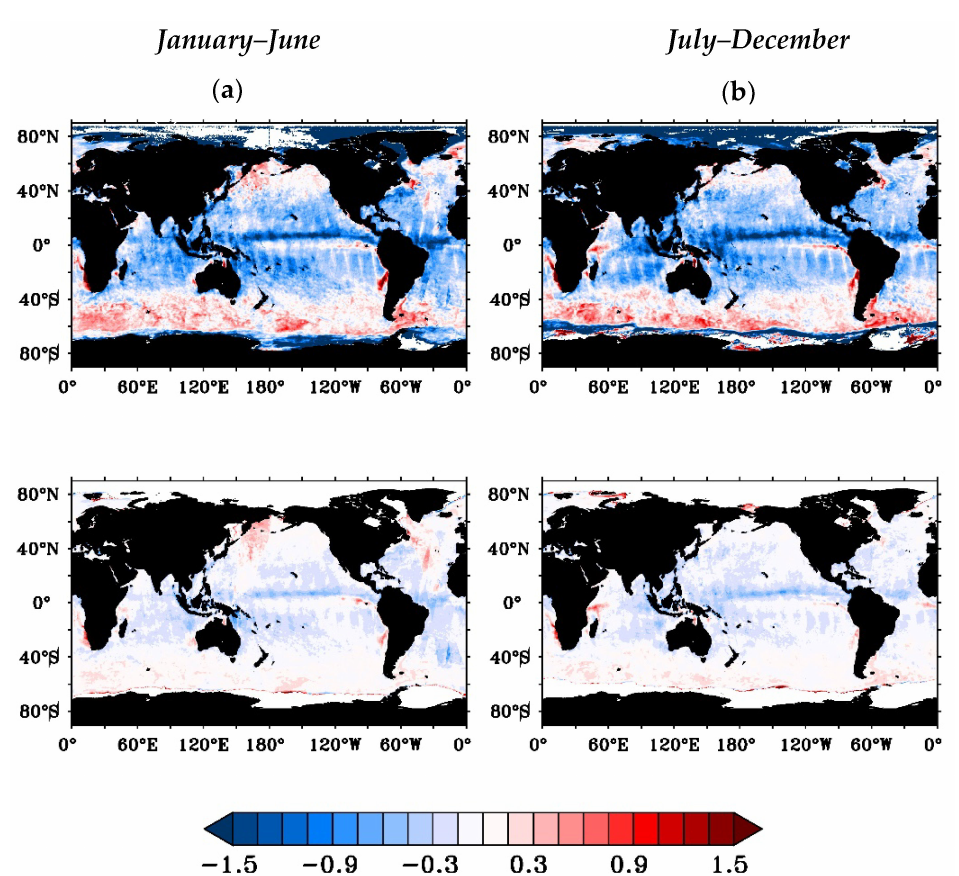
Figure 7. Bias between ( a ) NCMRWF wind speed and SCATSAT-1 wind speed ( b ) Particle filter-based reanalyzed wind speed and SCATSAT-1 wind speed between Jan–Jun 2018 and Jul–Dec